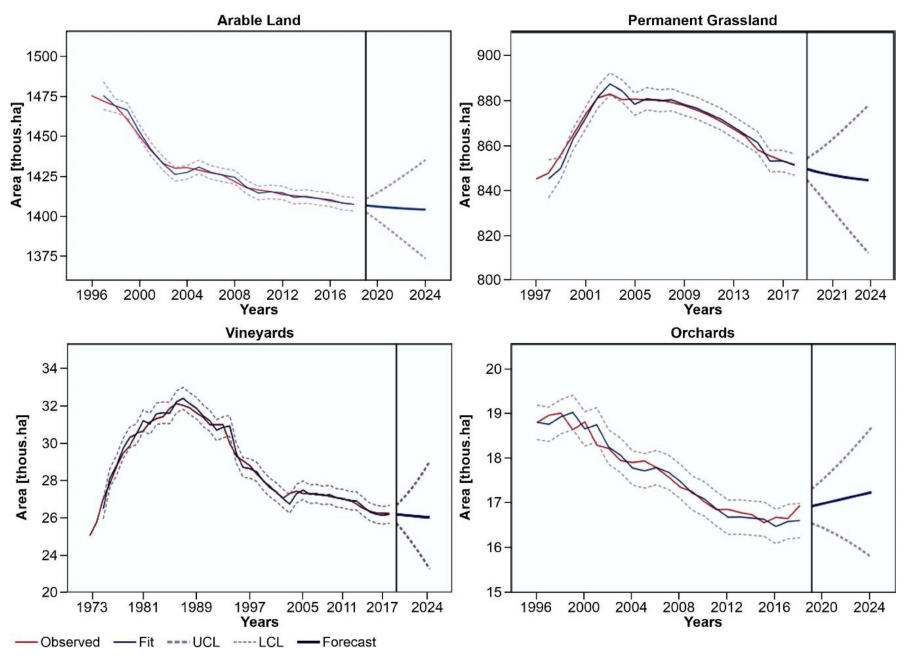
Figure 5. Observed, smoothed, and forecast series with 95% confidence bounds of ARIMA or Brown’s exponential models of arable land, permanent grassland, vineyards, and orchards at selected time